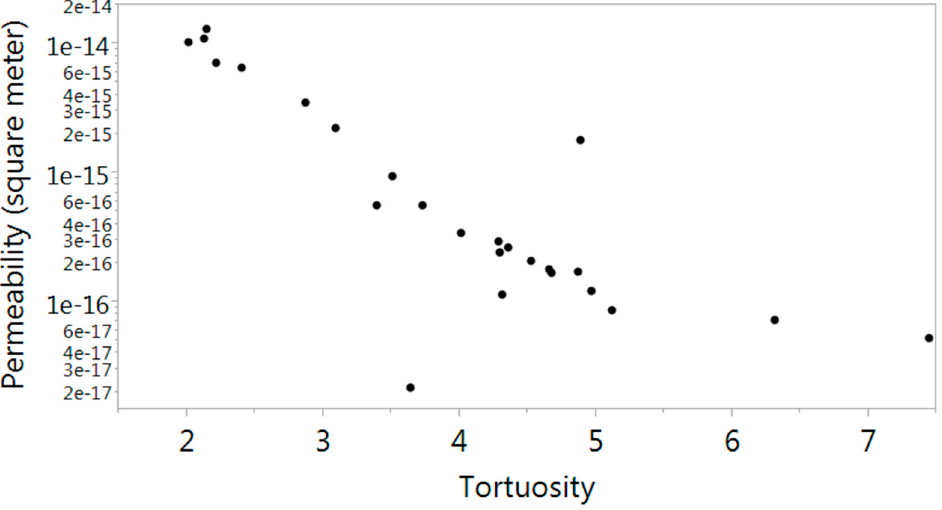
Figure 10. Scatter plot between tortuosity and intrinsic permeability (m 2 ).